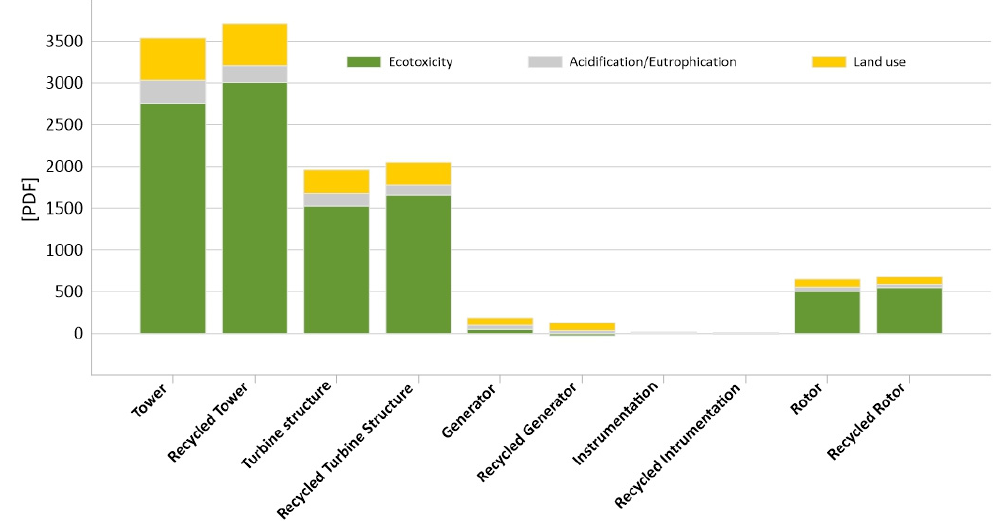
Figure 8. Results of characterization of environmental impacts occurring during the life cycle of elements of the construction of an innovative wind power plant comparison of results with and without recycling for the ecosystem quality categories.